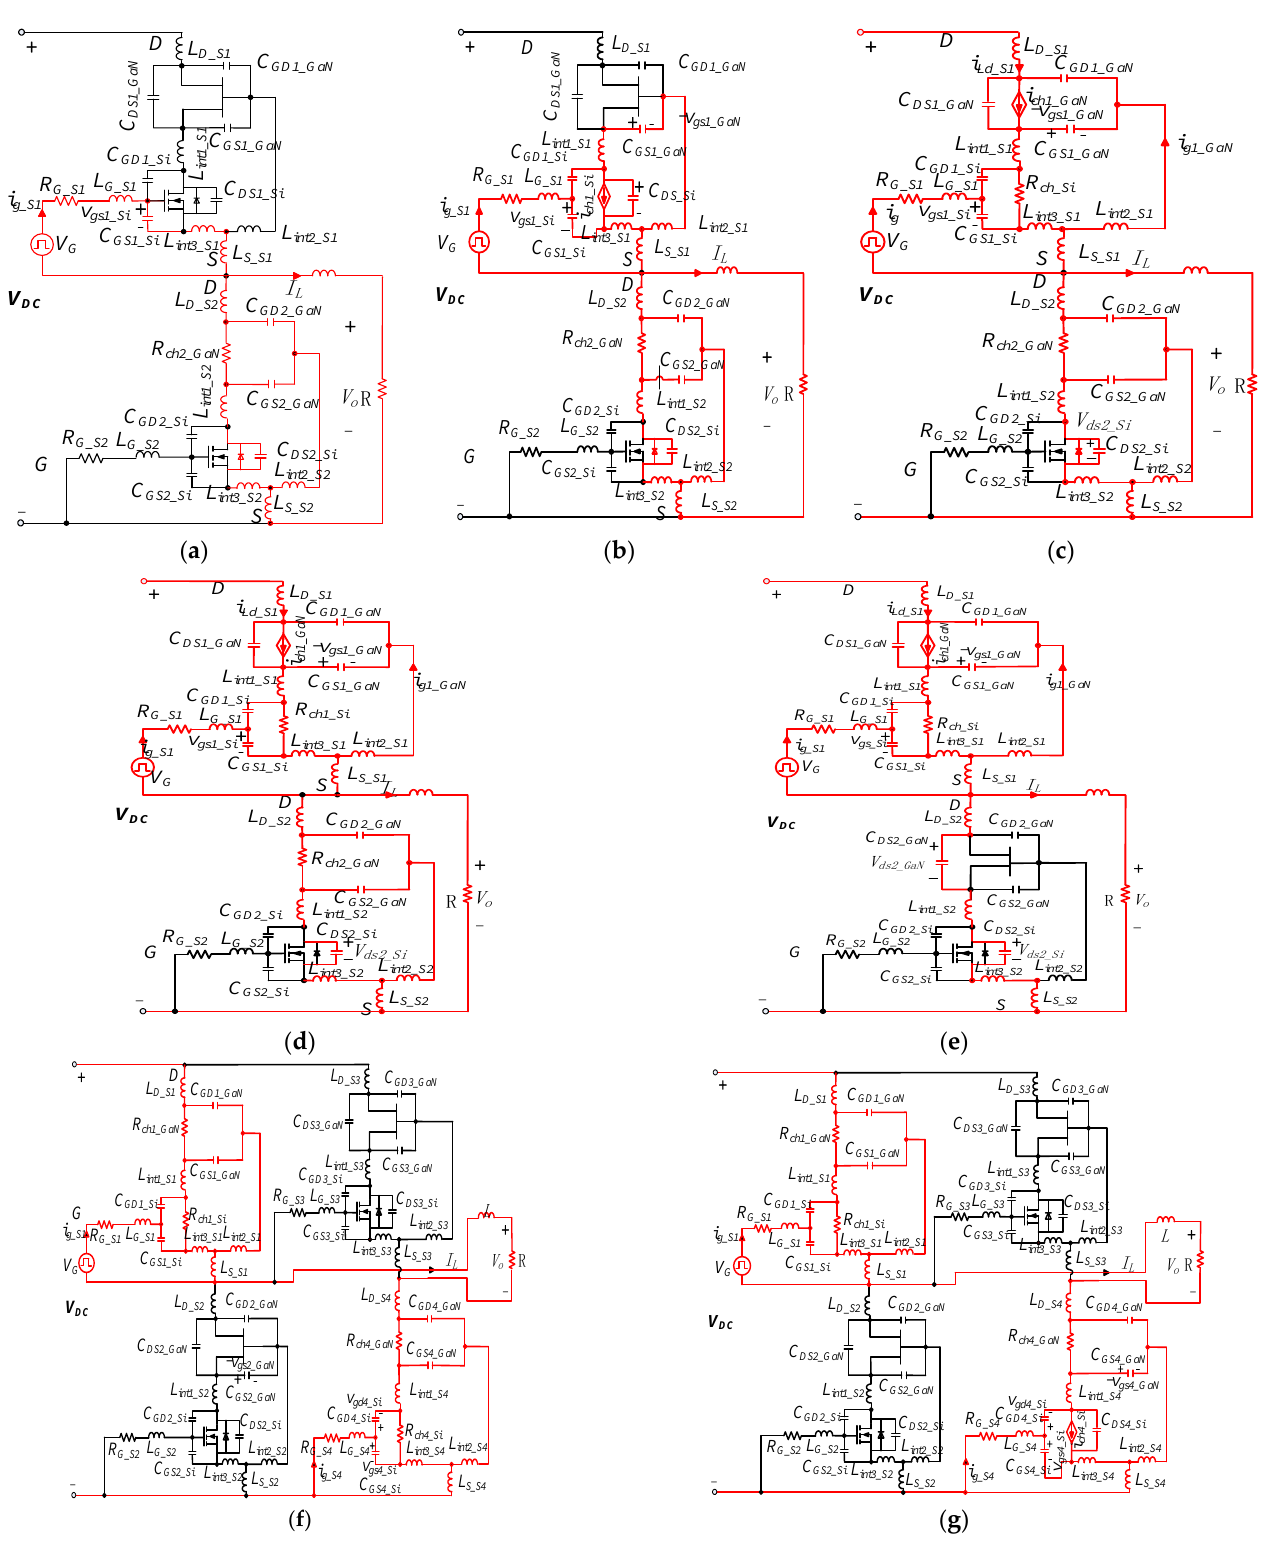
Figure 3. The equivalent circuit of positive turn-on stage and positive turn-off stage. ( a ) Positive turn-on I; ( b ) Positive turn-on II; ( c ) Positive turn-on III and IV; ( d ) Positive turn-on V; ( e ) Positive turn-on VI; ( f ) Positive turn-off I; ( g ) Positive turn-off II.